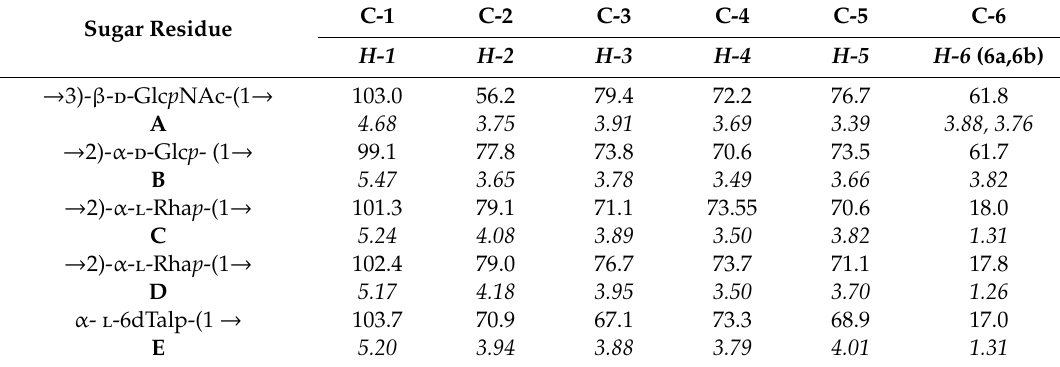
Table 1. 1 H and 13 C NMR chemical shifts ( δ , ppm) of the O-deacetylated polysaccharide (DPS) from Pectobacterium sp. F160.